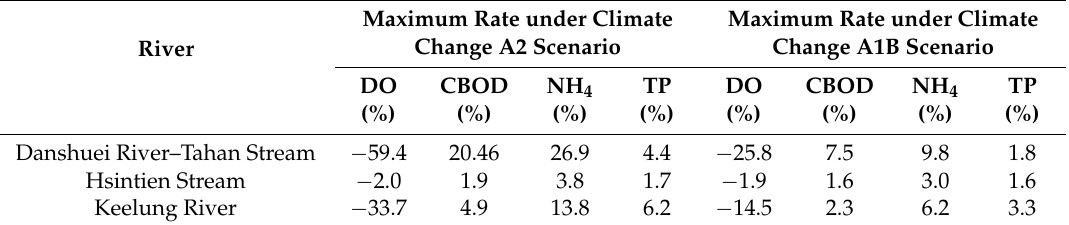
Table 7. Maximum rate of water quality state variables under climate change scenarios A2 and